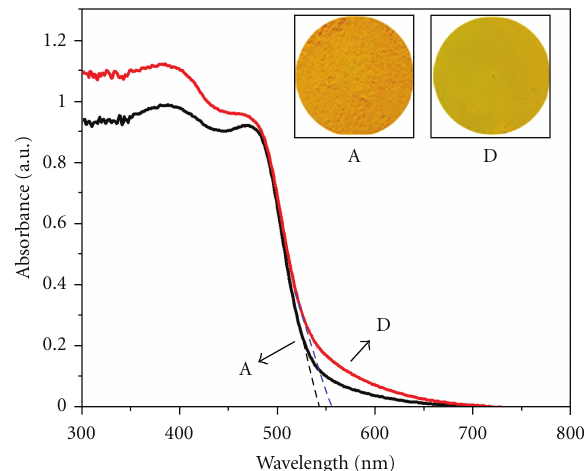
Figure 2: UV-visible absorption spectra and corresponding colors (inset) of sample A and